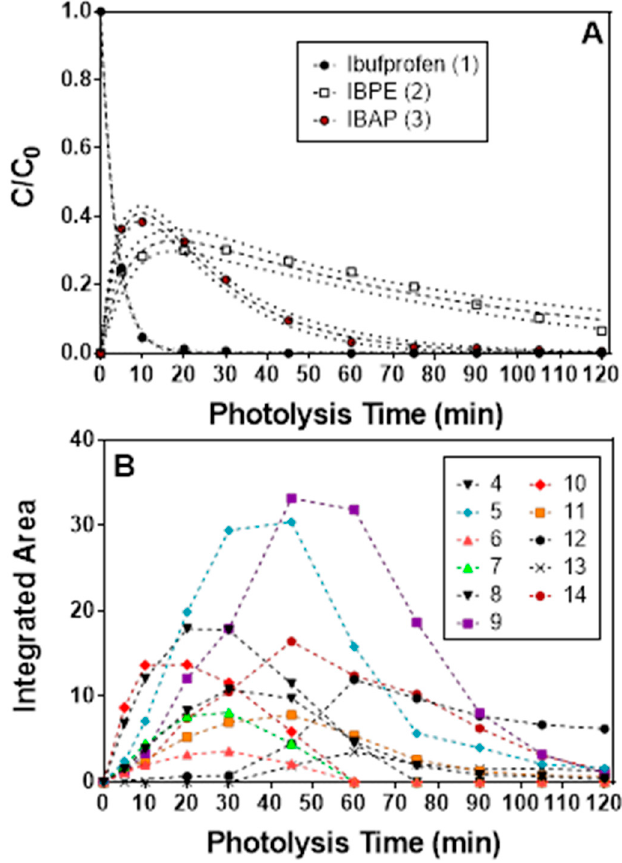
Figure 14. ( a ) Zeroth-order degradation plot for IBP, IBPE, and IBAP treated with BiOCl. This was derived via HPLC-DAD at 210-nm. ( b ) Integrated areas for signals corresponding with proposed intermediates. Said intermediates are identified in Table 3. Reused with permission from reference [118]. Copyright Elsevier 2018.